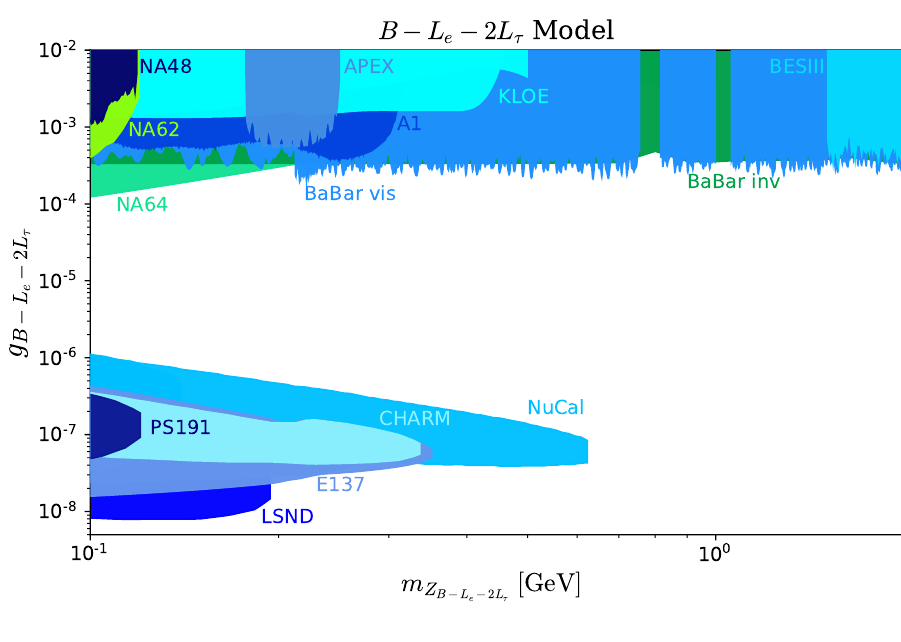
Figure 11 . Similar to figure 10 but for the B − L e − 2 L τ